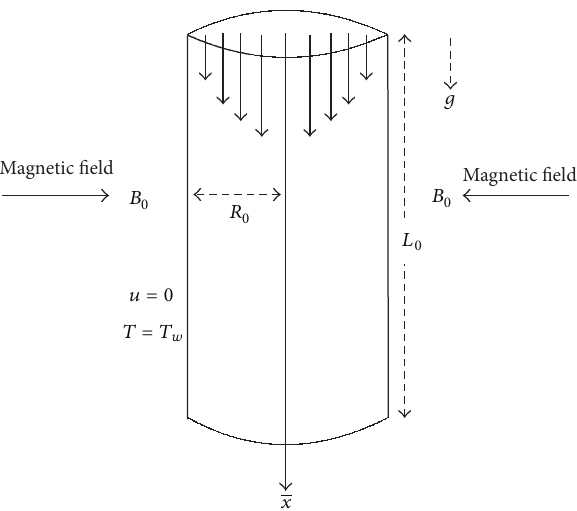
Figure 1: Geometry of the